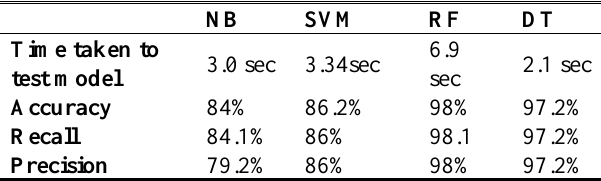
Table 7. Test Results of 24 attributes.